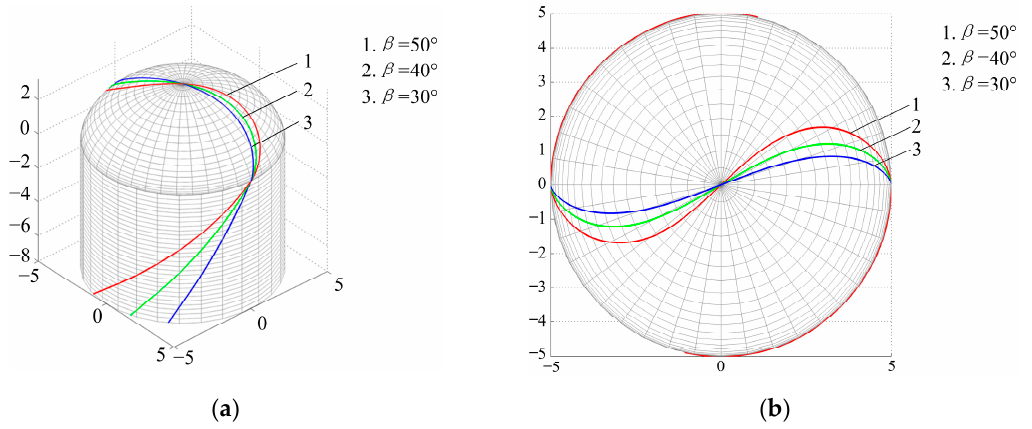
Figure 2. Cutting edge curve simulation of revolving cycloid milling cutter for different helical angles: ( a ) The cutting edge curve simulation for a cylindrical edge; ( b ) the cutting edge curve simulation for end edge.